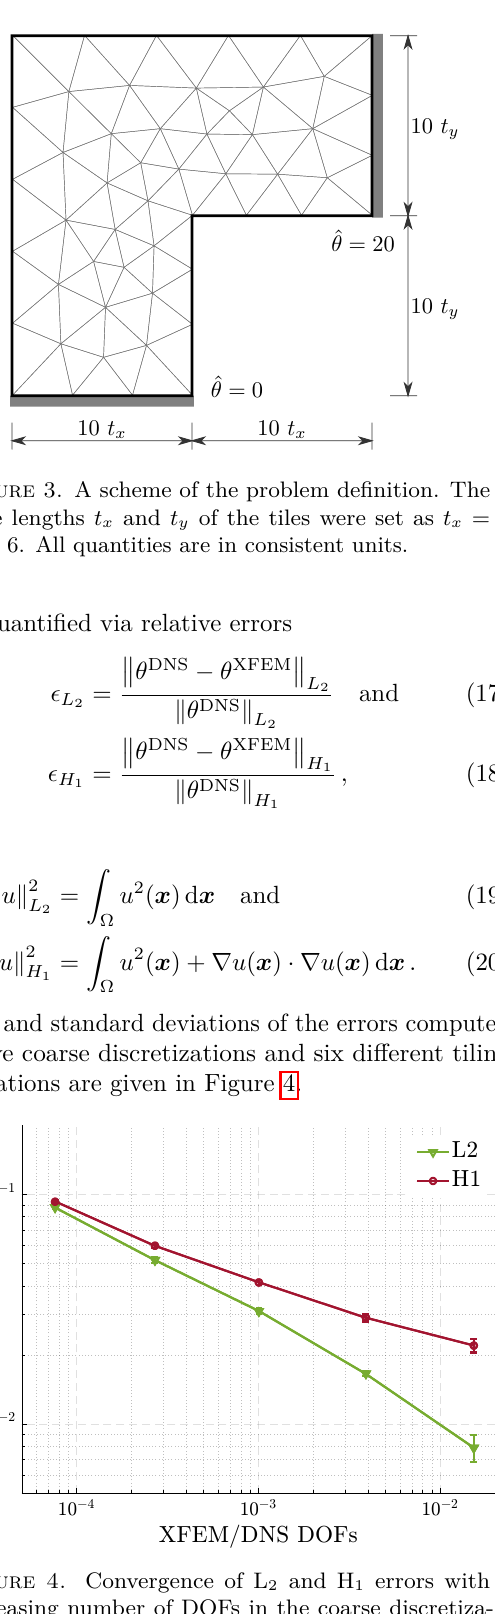
2 and H 1 errors with